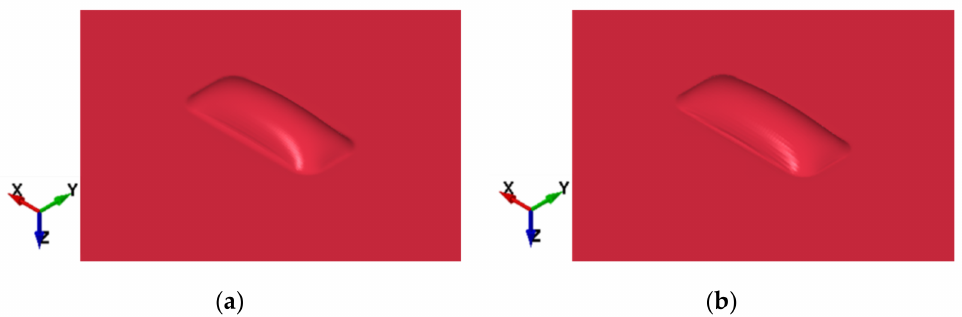
Figure 11. Final shape of free bulge model by finite element analysis for ( a ) free bulge 1 and ( b ) free bulge